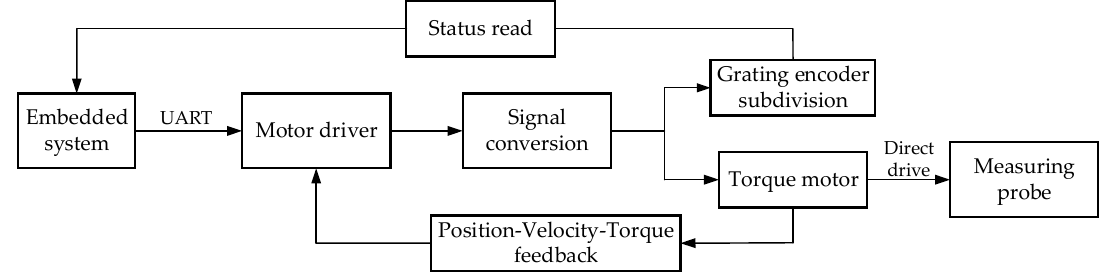
Figure 4. Architecture diagram of embedded platform.